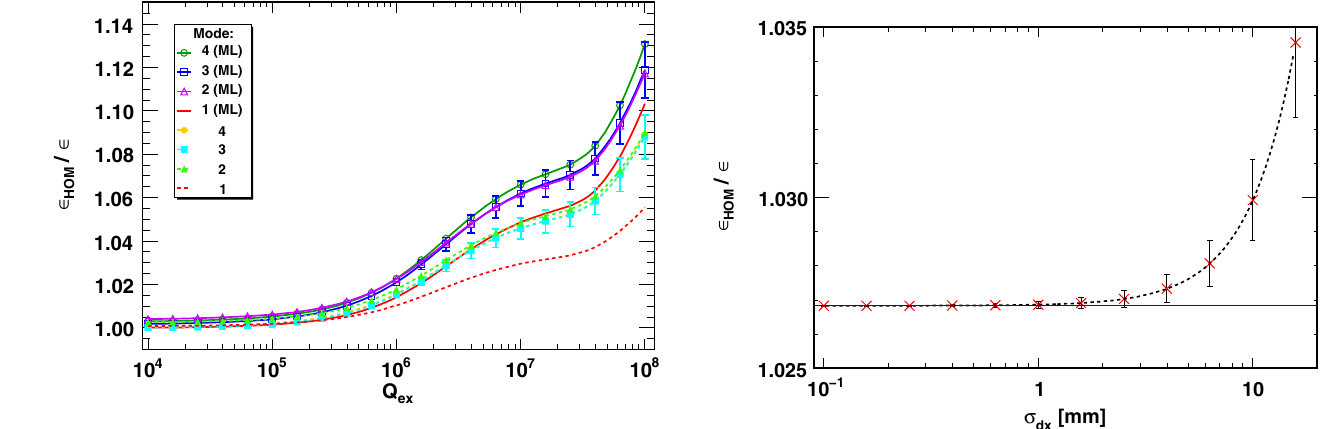
FIG. 31. Average transverse phase space increase against the and for different chopping patterns on (ML) and off damping Q ex a resonance. The error bars are only plotted for the 50 = 80 chopping pattern and about the same for the other cases.